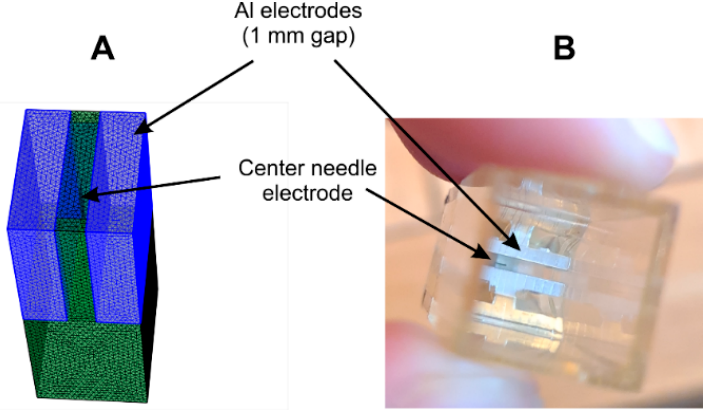
Figure 2. The mesh ( A ) and the photograph of the prototype ( B ) of the dielectrophoresis-assisted electroporation cuvette.